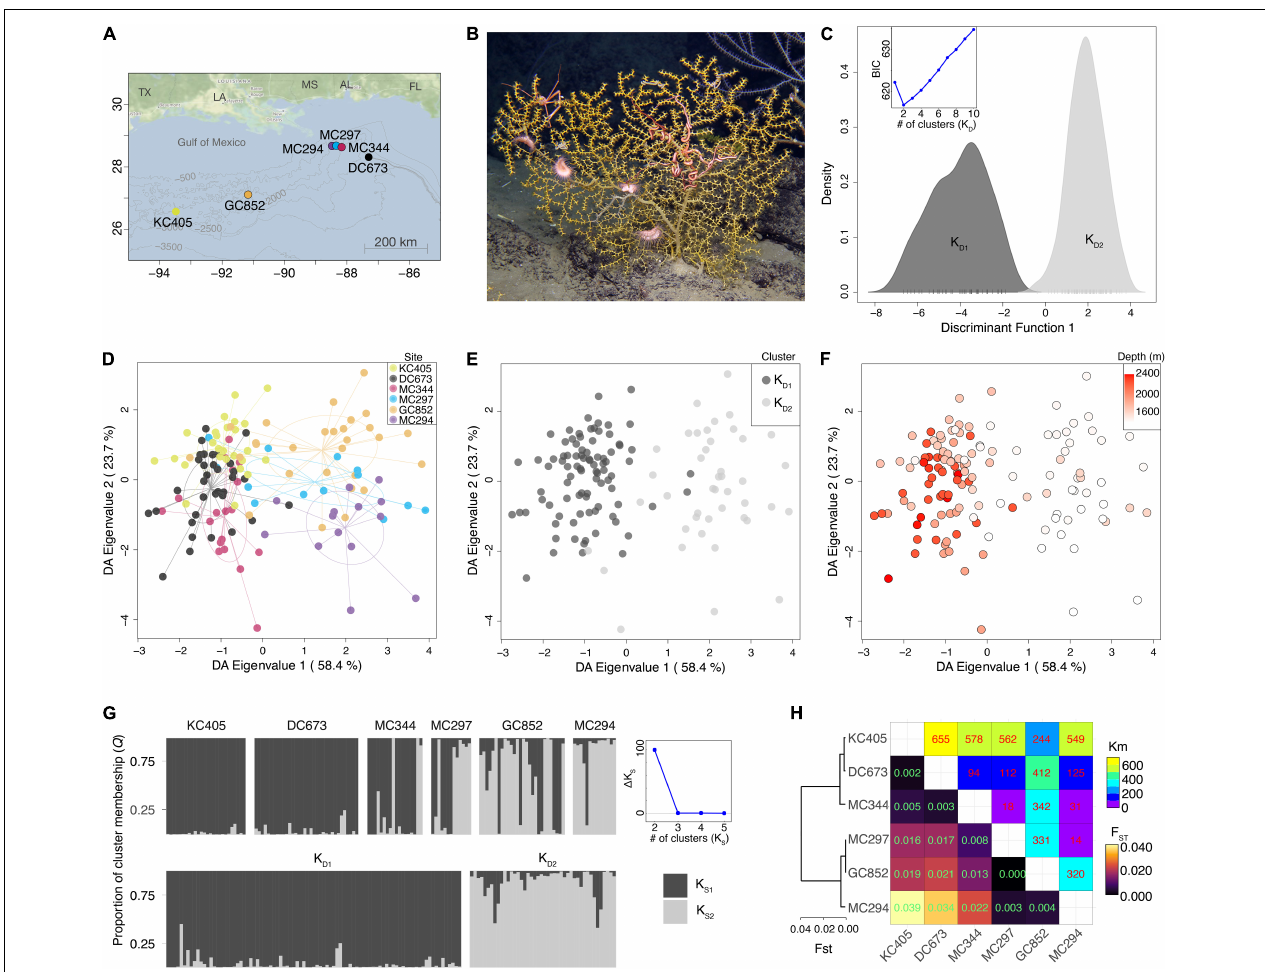
FIGURE 1 | Population genetic structure of Paramuricea biscaya in the northern Gulf of Mexico. (A) Map showing the study sites in the Gulf of Mexico. (B) Image of Paramuricea biscaya in its natural habitat at GC852 in the Gulf of Mexico, courtesy of F. Girard and ECOGIG. (C) Density plots of the first discriminant function estimated from DAPC with no sampling location priors. Insert scatter-line plot shows the BIC values for each cluster number (K) tested. K D1 and K D2 are clusters 1 and 2 identified by DAPC, respectively. (D) Scatter plot of the first discriminant analysis (DA) eigenvalues calculated by DAPC with sampling location priors. Individuals are color-coded by sampling site. Colors correspond to sites in (A) . (E) Same scatter plot as in (D) but color-coded by DAPC cluster assignment as in (C) . (F) Same scatter plot as in (D) but color-coded by individual sampling depth. (G) Bayesian population clustering analyses in STRUCTURE. Bars represent individuals grouped by sampling site (top) and DAPC cluster membership (bottom). The color distributions of each bar are proportional to the cluster membership proportions, K D1 and K D2 , estimated by STRUCTURE. The scatter-line plot on the right shows the ad hoc statistic (cid:49) K, the second-order rate of change of the likelihood function for each cluster number (K) tested. (H) Heatmap of pairwise F ST indices of genetic differentiation among sampling sites. The dendrogram on the left was constructed using the Neighbor-Joining algorithm on the F ST